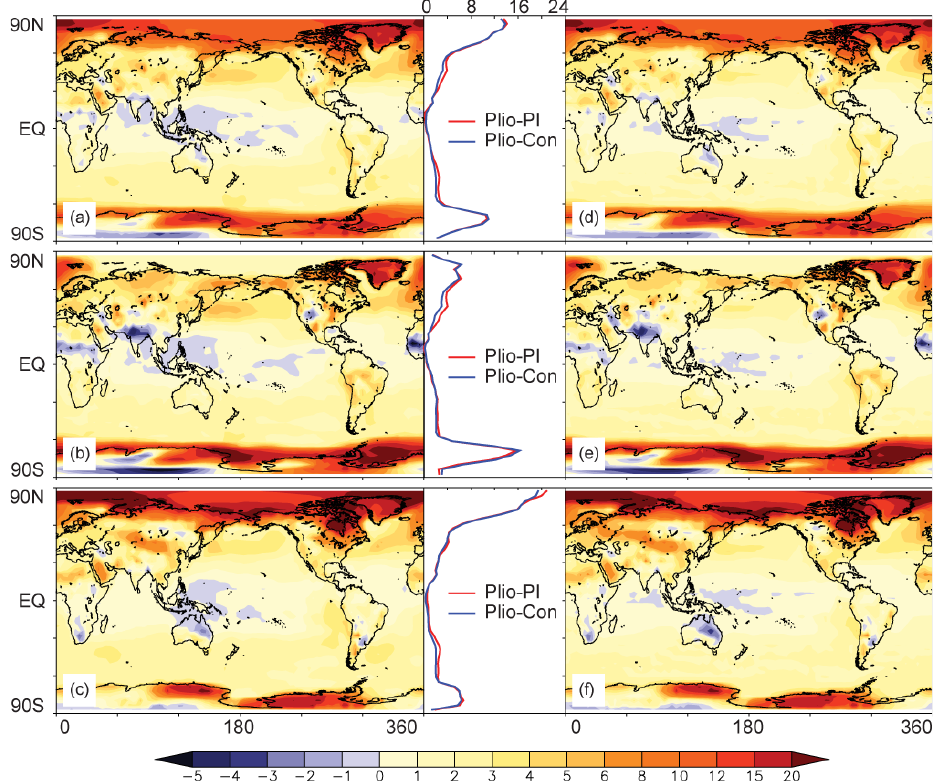
Fig. 6. SAT anomalies ( ◦ C), left column for the anomalies between the mid-Pliocene and the pre-industrial experiment, right column for the anomalies between the mid-Pliocene and the control experiment. (a) and (d) for annual mean, (b) and (e) for boreal summer, and (c) and (f) for boreal winter. The bold lines in the middle show zonal mean values for these